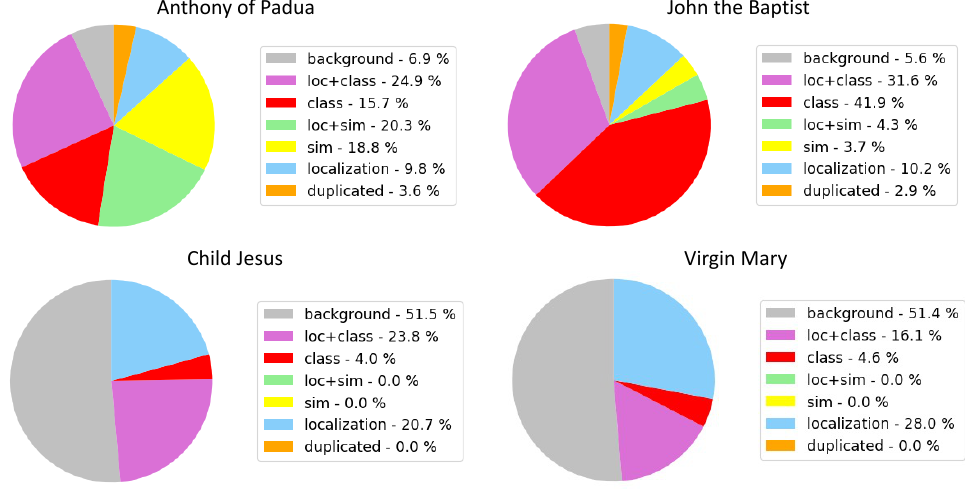
Figure 6. FP error distributions —The FP error analysis for two ArtDL 2.0 classes (Anthony of Padua and John the Baptist) and two IconArt classes (Child Jesus and Virgin Mary) shows a difference in error type distribution between the data